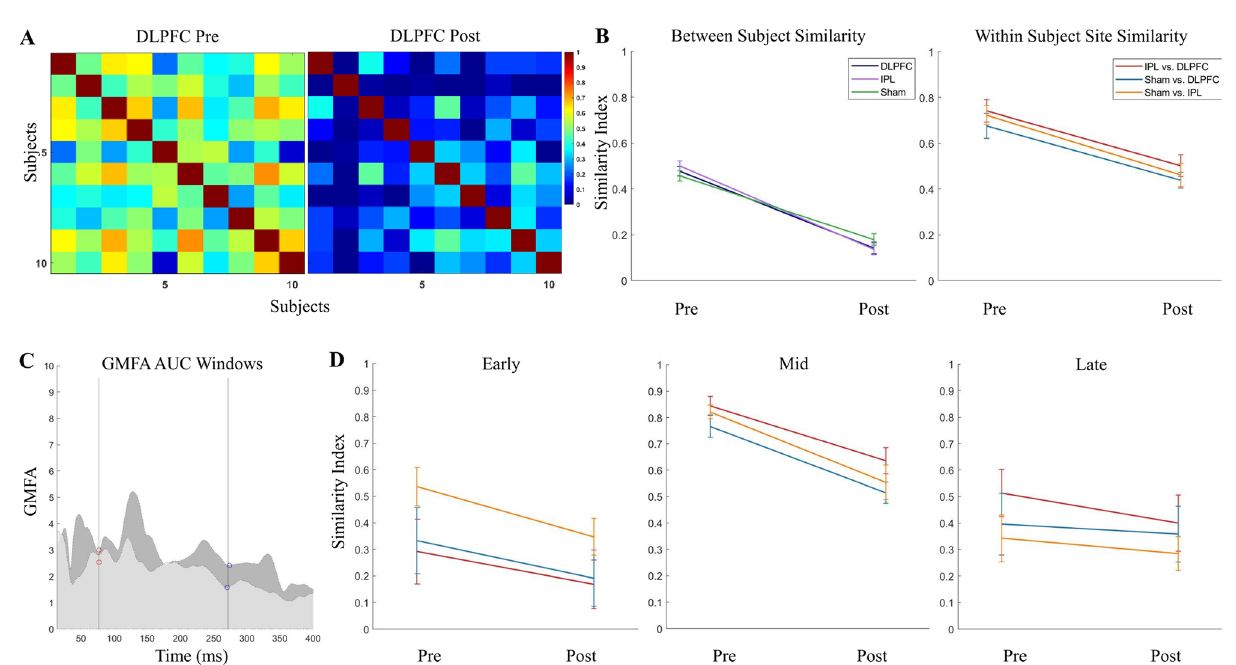
Figure 3. Specificity of TEPs (cosine similarity) before and after removing AEPs in the younger cohort. ( A ) Between-subject similarity index grids pre- and post-removal of AEP components. ( B ) Between-subject similarity index average (calculated from half of the grid, excluding the diagonal) pre- and post-removal (left), and within-subject stimulation site similarity (calculated as the average of the diagonal of IPL/DLPFC, sham/ DLPFC, and sham/IPL grids; right). ( C ) Time windows used for within-subject site similarity in three windows (early: 14–77.24 ms, mid: 77.24–271.72 ms, late: 271.72–400 ms), defined using the post-removal GMFP from DLPFC (darker) and IPL (lighter). ( D ) Within-subject stimulation site similarity pre and post removal in early, mid and late latency